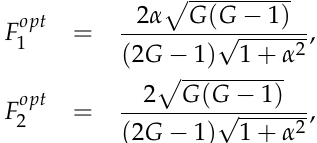
(trace A ); B 1 (trace s 12